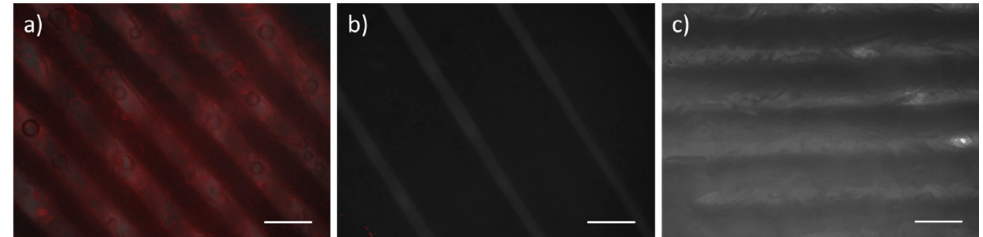
Figure 4. Epifluorescent images of CDHA scaffolds. The scaffolds were immersed in the solution containing 12.5 μ g/mL of Cy5-labeled ( a ) HA-Fn, ( b ) OB-Fn, and ( c ) WT-Fn. Scale bar is 500 nm.